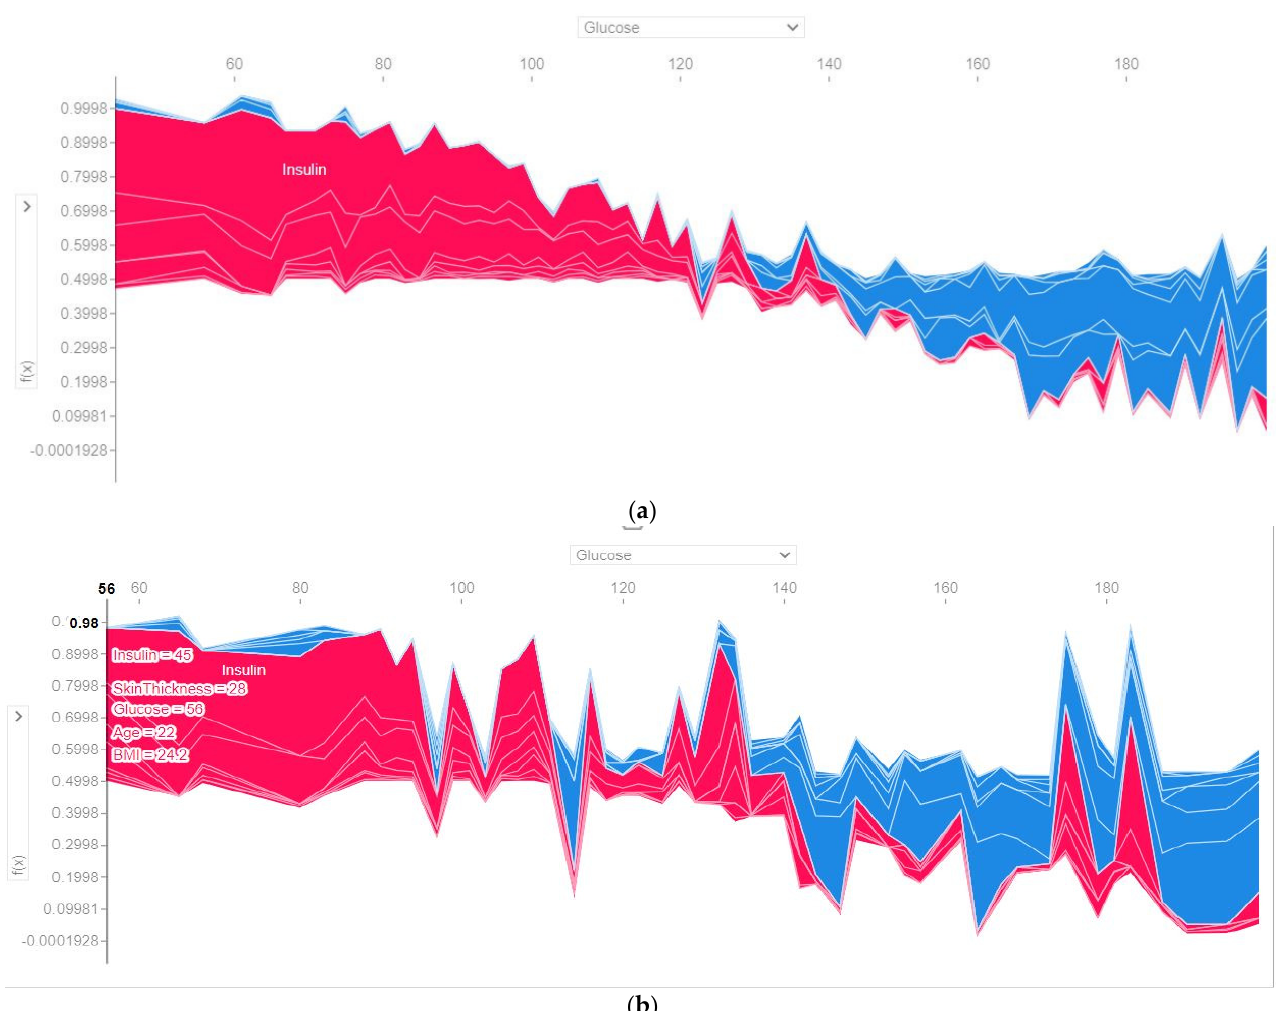
Figure 9. Output probability based on the sample order by the similarity of the voting classifier using ( a ) all folds ( b ) last fold and the sample order by the output value of the voting classifier using ( c ) all folds ( d ) last fold.